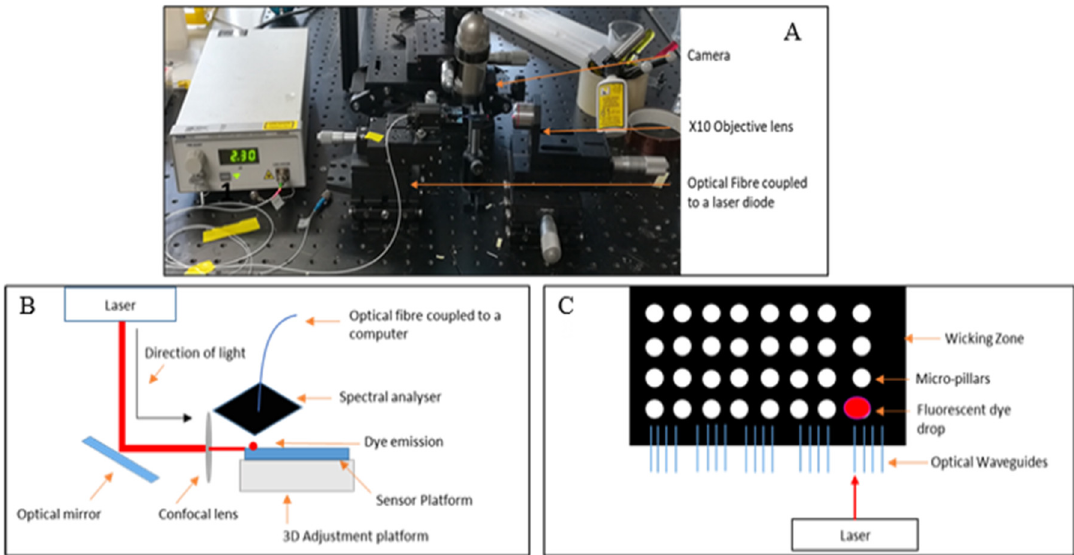
Figure 3. Optical set up for waveguide testing ( A ), schematic of the optical set up used for the fluo- rescence studies ( B ), and schematic of the sensor platform with the location of the fluorescent dye ( C